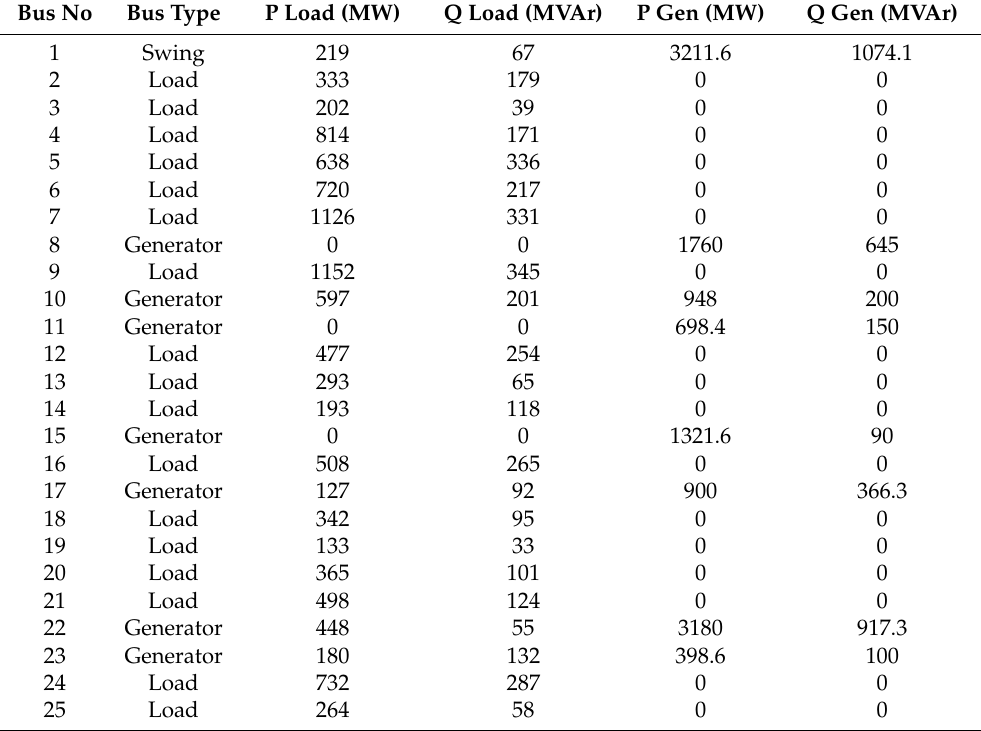
Table A1. Java-Indonesian grid load and generation data [34].